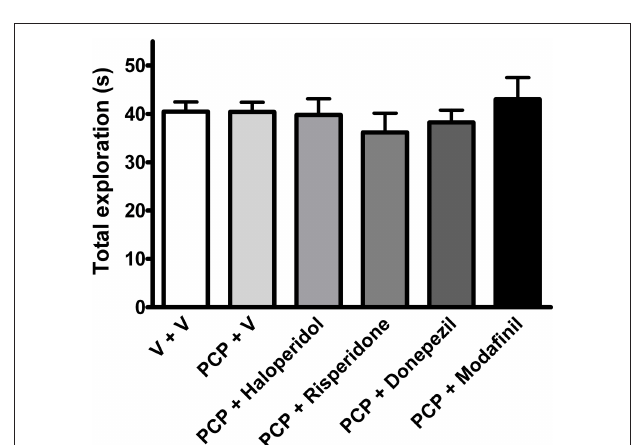
Figure 3 | The effects of vehicle ( n = 31), haloperidol (0.1 mg/kg, n = 9), risperidone (0.2 mg/kg, n = 12), donepezil (3 mg/kg, n = 12), and modafinil (64 mg/kg, n = 10) on total exploration time in the NOr task in rats sub-chronically treated with PCP ( n = 33). Data expressed as mean +